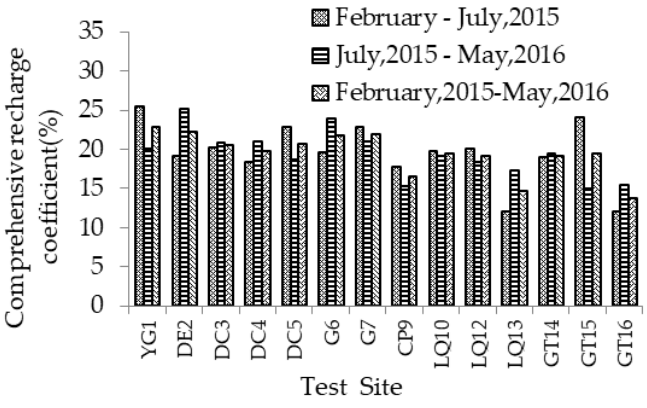
Figure 9. The recharge coefficient of groundwater in different periods.